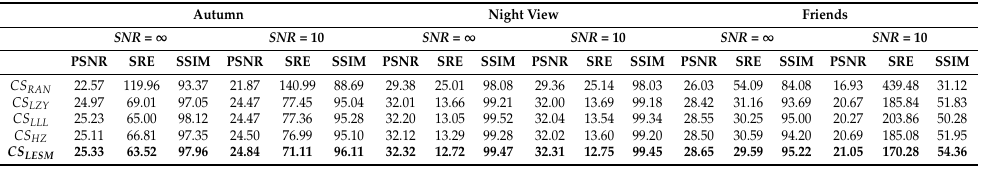
Table 4. The PSNRs (dB), SREs and SSIM (%) of VAU images taken by ourselves for five sensing matrices with different